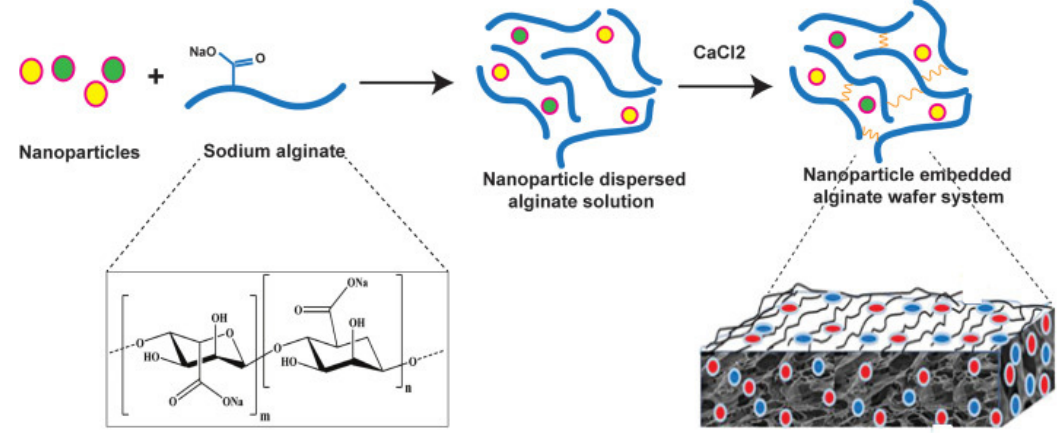
Figure 13. Schematic representation of the preparation of calcium alginate wafer dressing. Reprinted from [104] with permission.